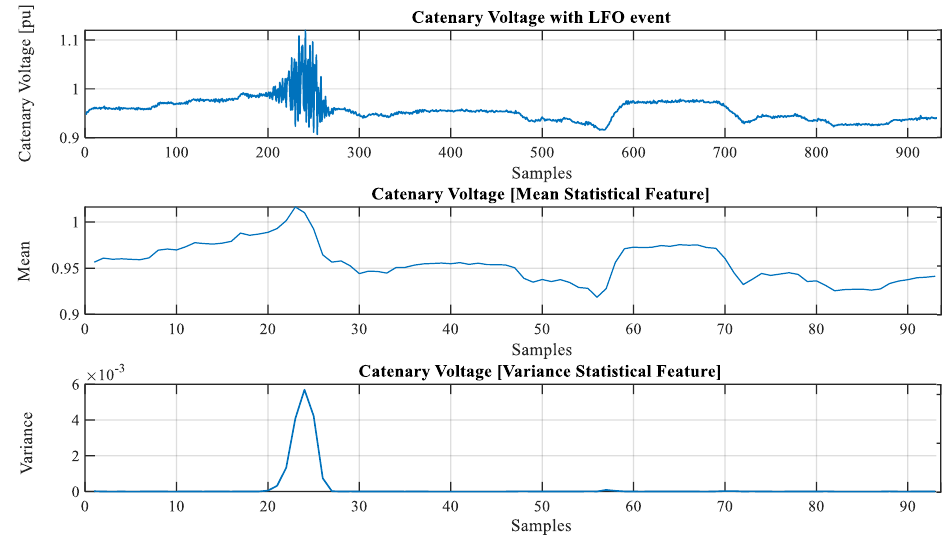
Figure 6. Statistical time-domain features from catenary voltage (mean and variance features).